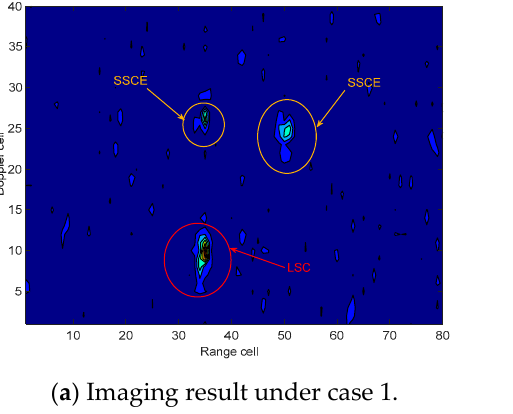
Figure 5. Imaging results of 2D-GP-SOONE algorithm.